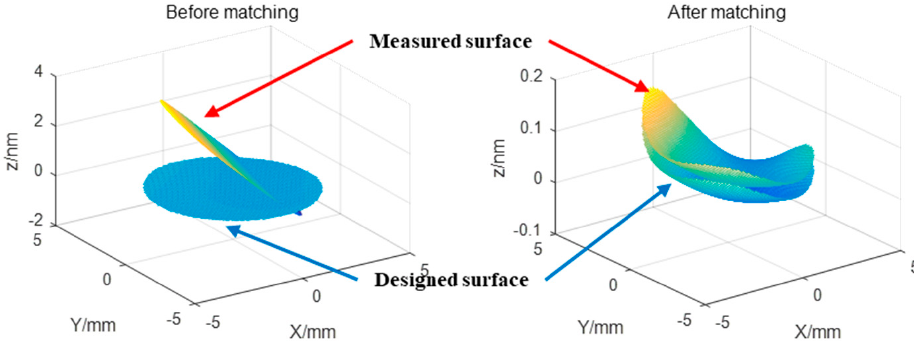
make the measured surface approximates the theoretical to the maximum extent as far as possible. as possible.